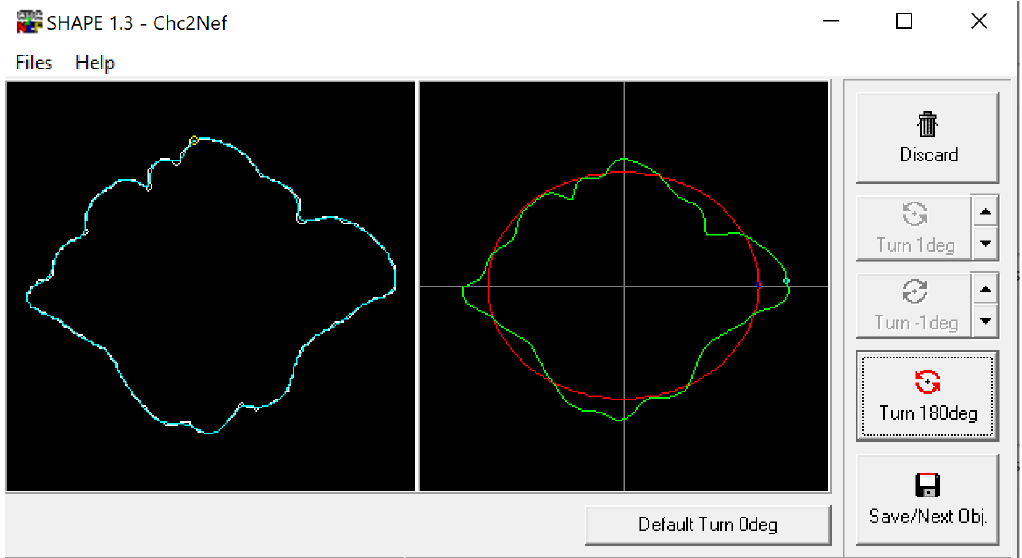
Figure 4. Example of frontal sinus outline ( left ) and accompanying analysis in the SHAPE v1.3 software using Chc2Nef ( right ). The software calculates coefficients to alter an ellipsis (red) to approximate the frontal sinus outline (green).